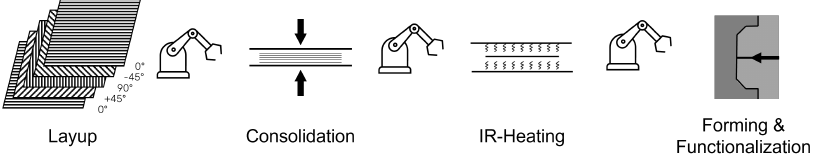
Figure 1. Processing of thermoplastic UD tapes by laying, consolidation, preheating, forming and